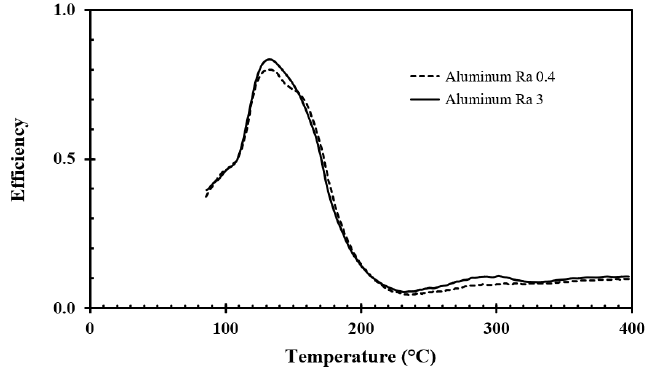
Figure 15. Average cooling efficiency for water droplets impinging onto the aluminum disc with surface roughnesses of Ra 0.4 and Ra 3 (marked on the figure).